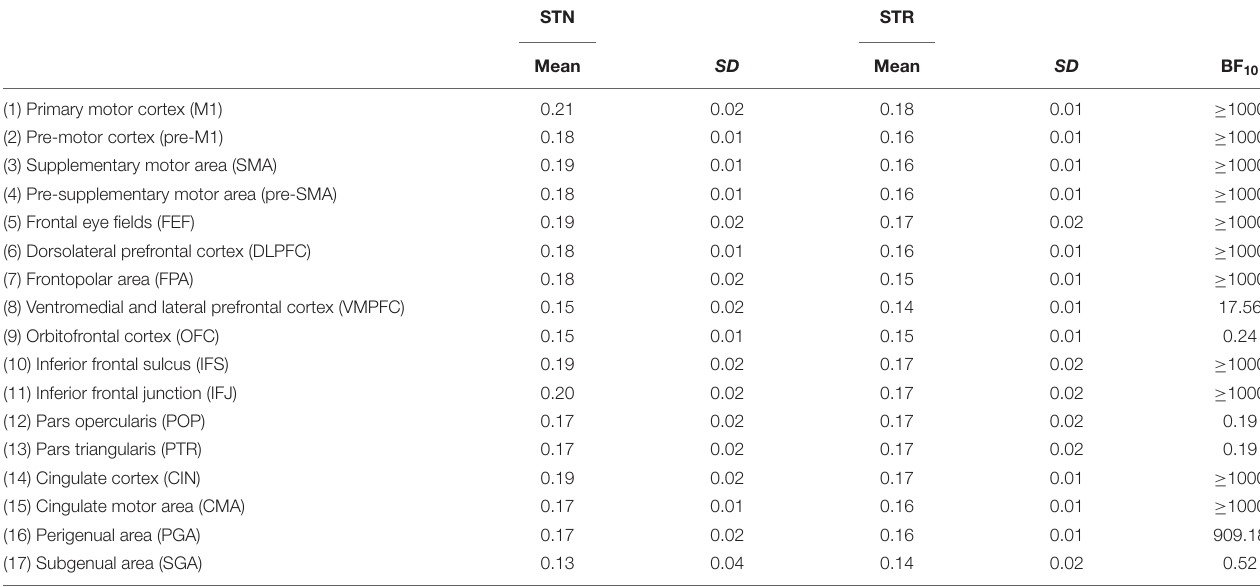
TABLE 4 | Summary statistics of the average seed ratios for the STN and STR to cortex averaged over hemispheres.